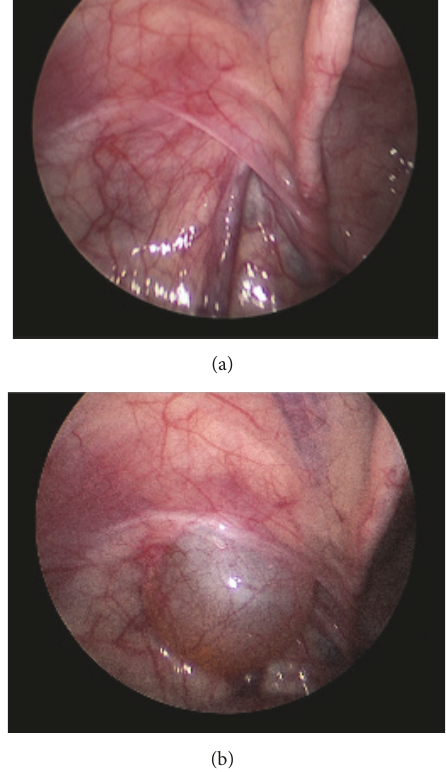
Figure 3: (a) Diagnostic laparoscopy. Left internal inguinal ring without palpation of the ipsilateral hemiscrotum. (b) Diagnostic laparoscopy. Left internal inguinal ring with palpation of the ipsilateral